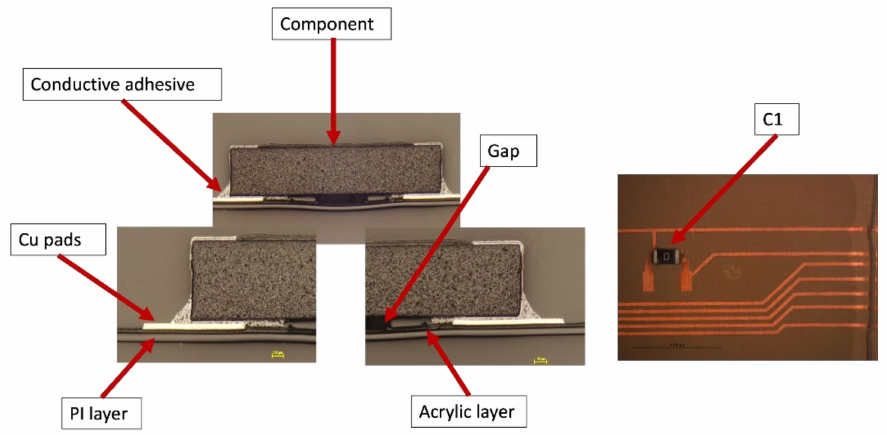
Figure 32. Cross-sectional images at 100 µ m for C1 component ( Left ). Top view of the component at 3000 µ m ( Right ).